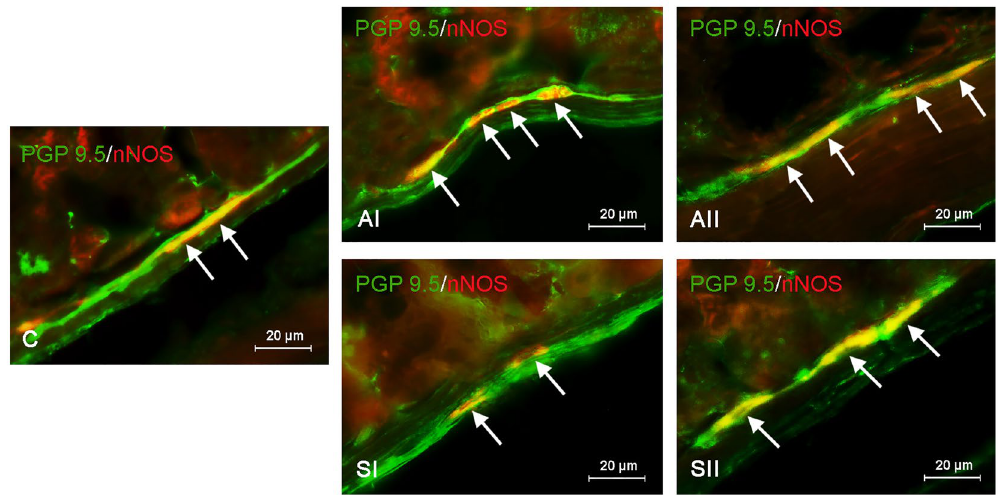
Figure 2. Distribution pattern of nerve cells immunoreactive to protein gene-product 9.5 (PGP 9.5)—used as a pan-neuronal marker and neuronal isoform of nitric oxide synthase (nNOS) in the submucous plexus (SG) of the mouse stomach under physiological conditions (C) and after administration of bisphenol A in a lower (AI) and higher dose (AII) and bisphenol S in a lower (SI) and higher dose (SII). The pictures are the result of the overlap of both stainings. The arrows are pointing to neurons immunoreactive for both—PGP 9.5 and nNOS.